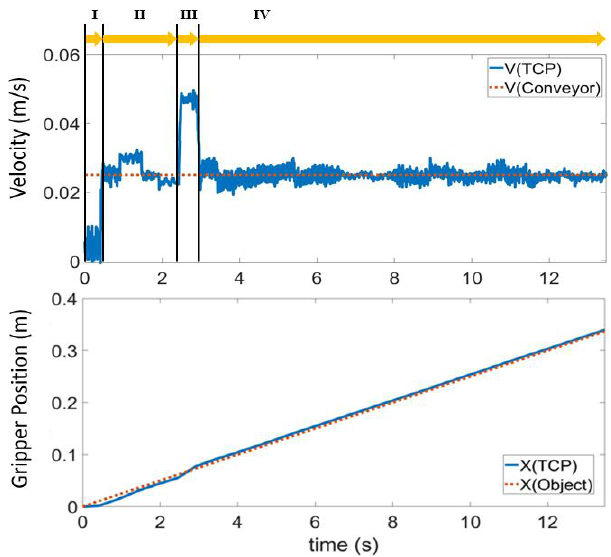
Figure 27. Comparison of speed and position of the TCP in tracking task.